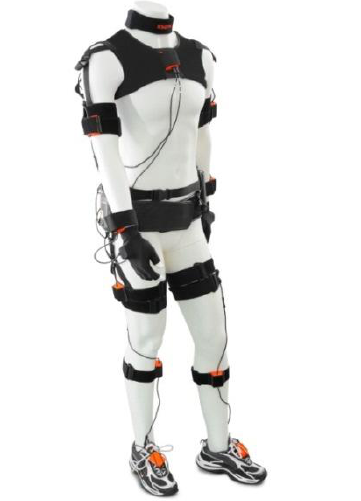
Figure 12. Commercial WS system based on inertial sensors: Xsens MVN. Reproduced with permission from